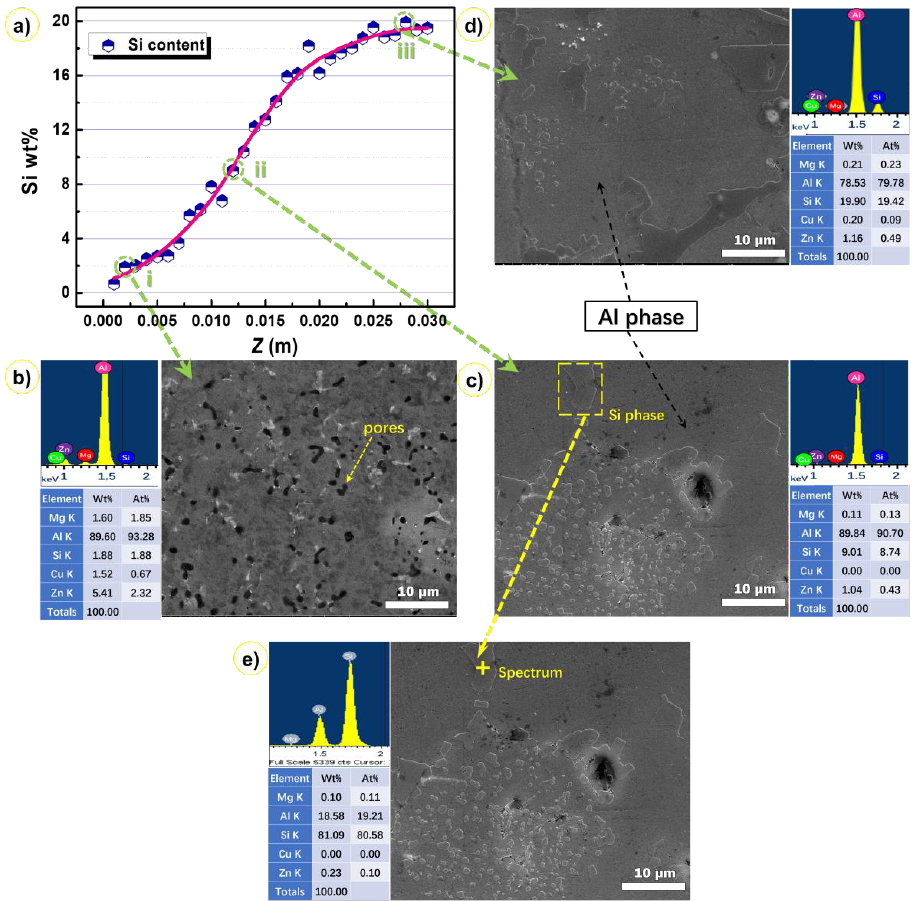
Figure 5. Silicon content and microstructures in the bimetallic gradient alloy. ( a ) Variation of silicon content in the 30 regions sampled, ( b ) microstructure and EDS of the lower region, ( c ) microstructure and EDS of the middle region, ( d ) microstructure and EDS of the upper region (the EDS data are obtained by an area scanning model), and ( e ) EDS spectrum of the rich-silicon